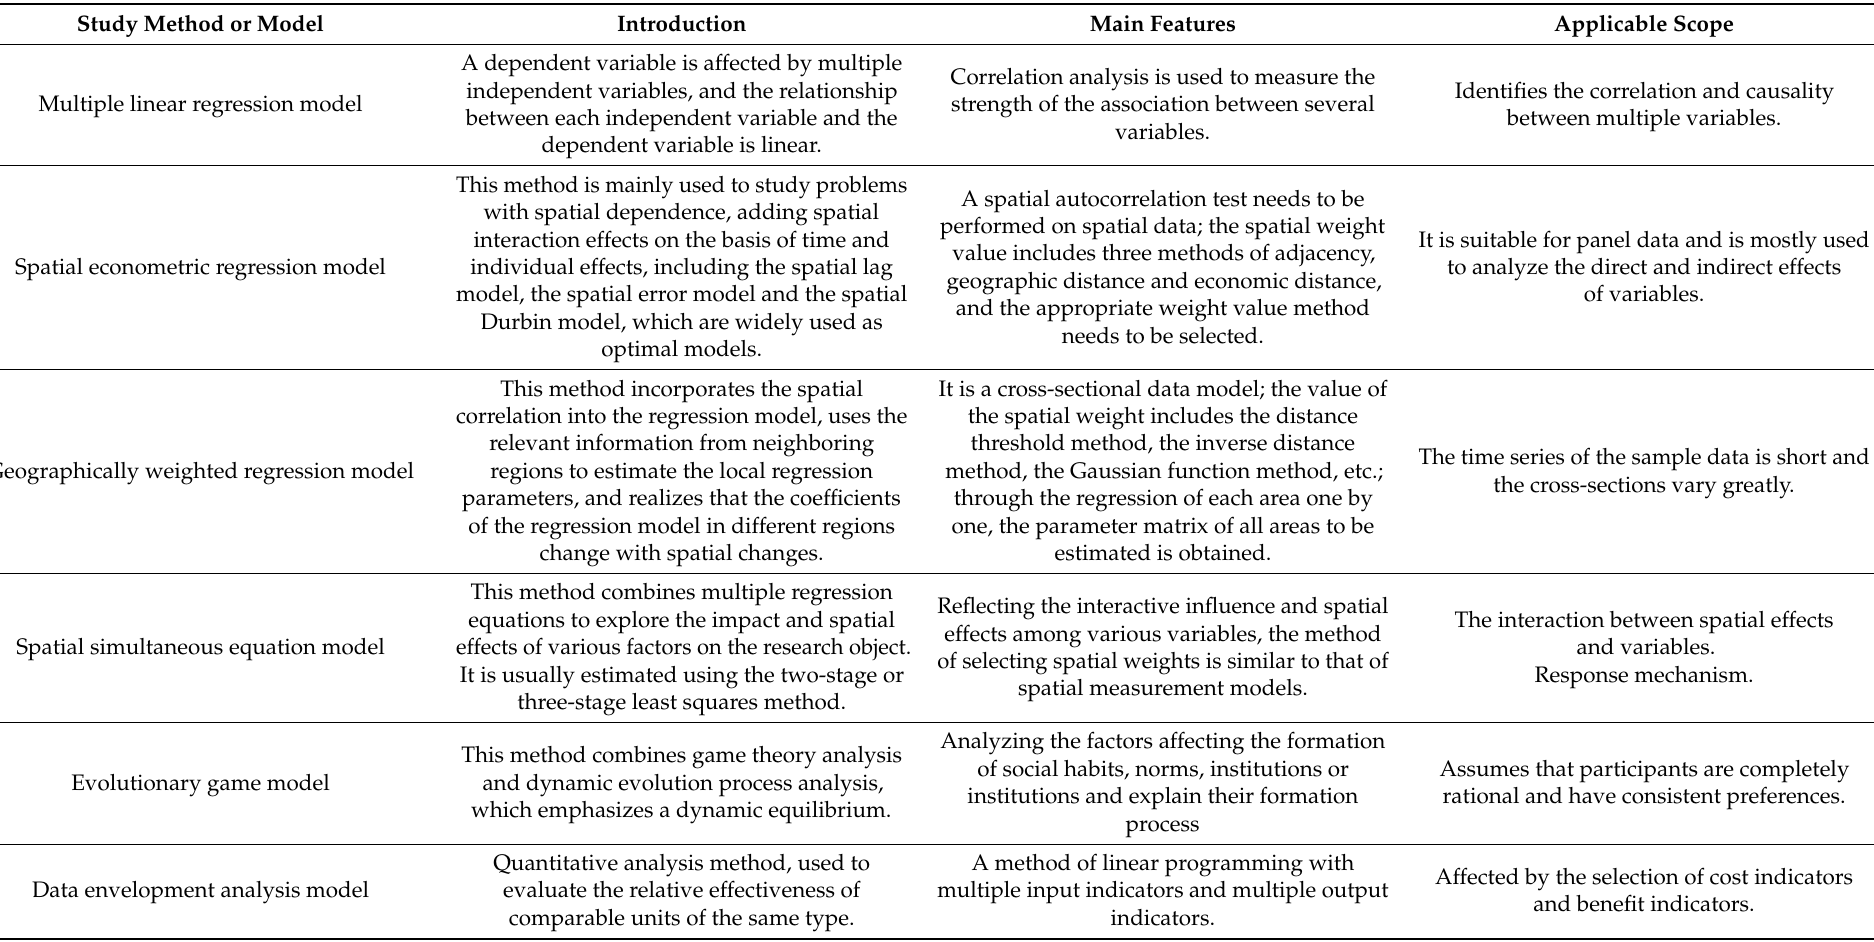
Table 4. Summary of empirical analysis and quantitative methods of haze pollution